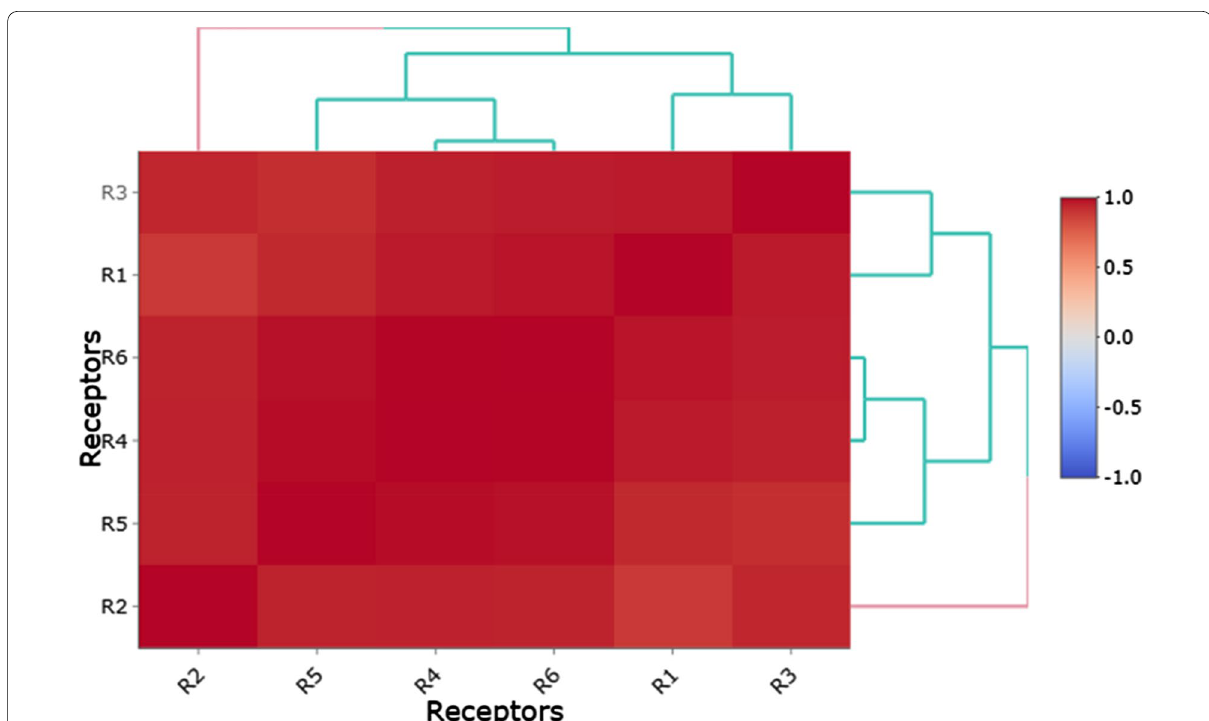
Fig. 7 Correlation of docking energies between studied active sites and affinity of their cavity to interact with target ligands. (R1 R3 FtsZ; R4 MerB; R5 RbmC and R6 = = = =